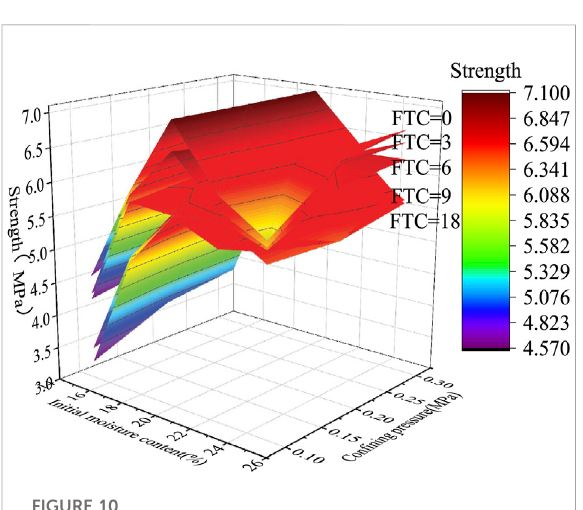
FIGURE 10 Three dimensional changes of con fi ning pressure, initial moisture content and strength under different freeze-thaw conditions.